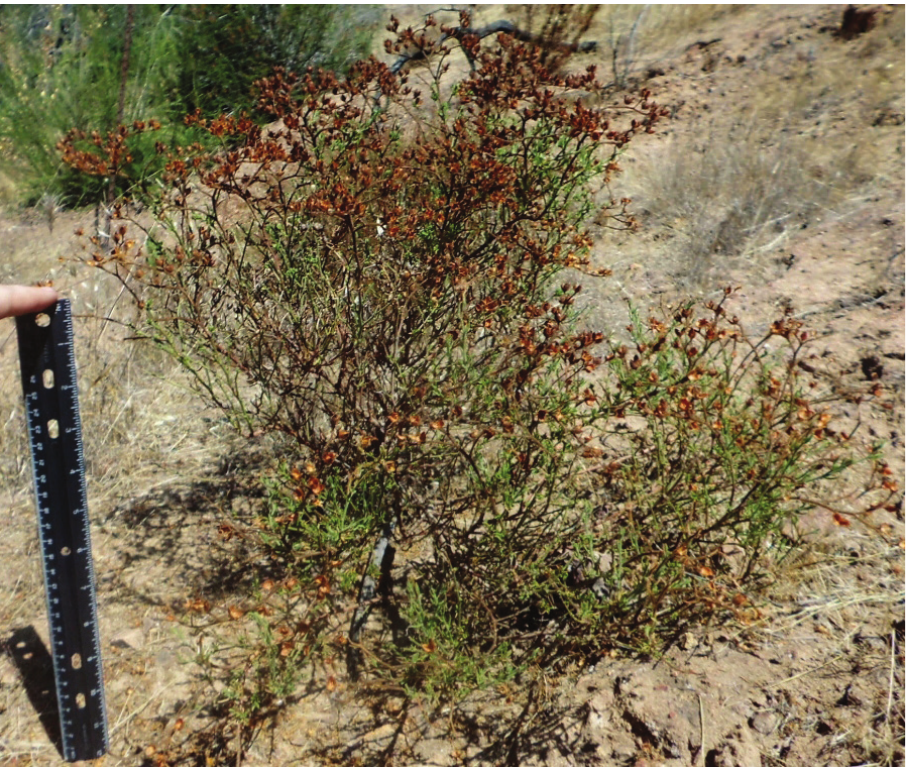
Figure 1. An individual from the current monitoring effort for Crocanthemum greenei . This particular individual, growing within an exclosure, had an initial stem measurement of 44 cm and is representative of size for non-browsed individuals.